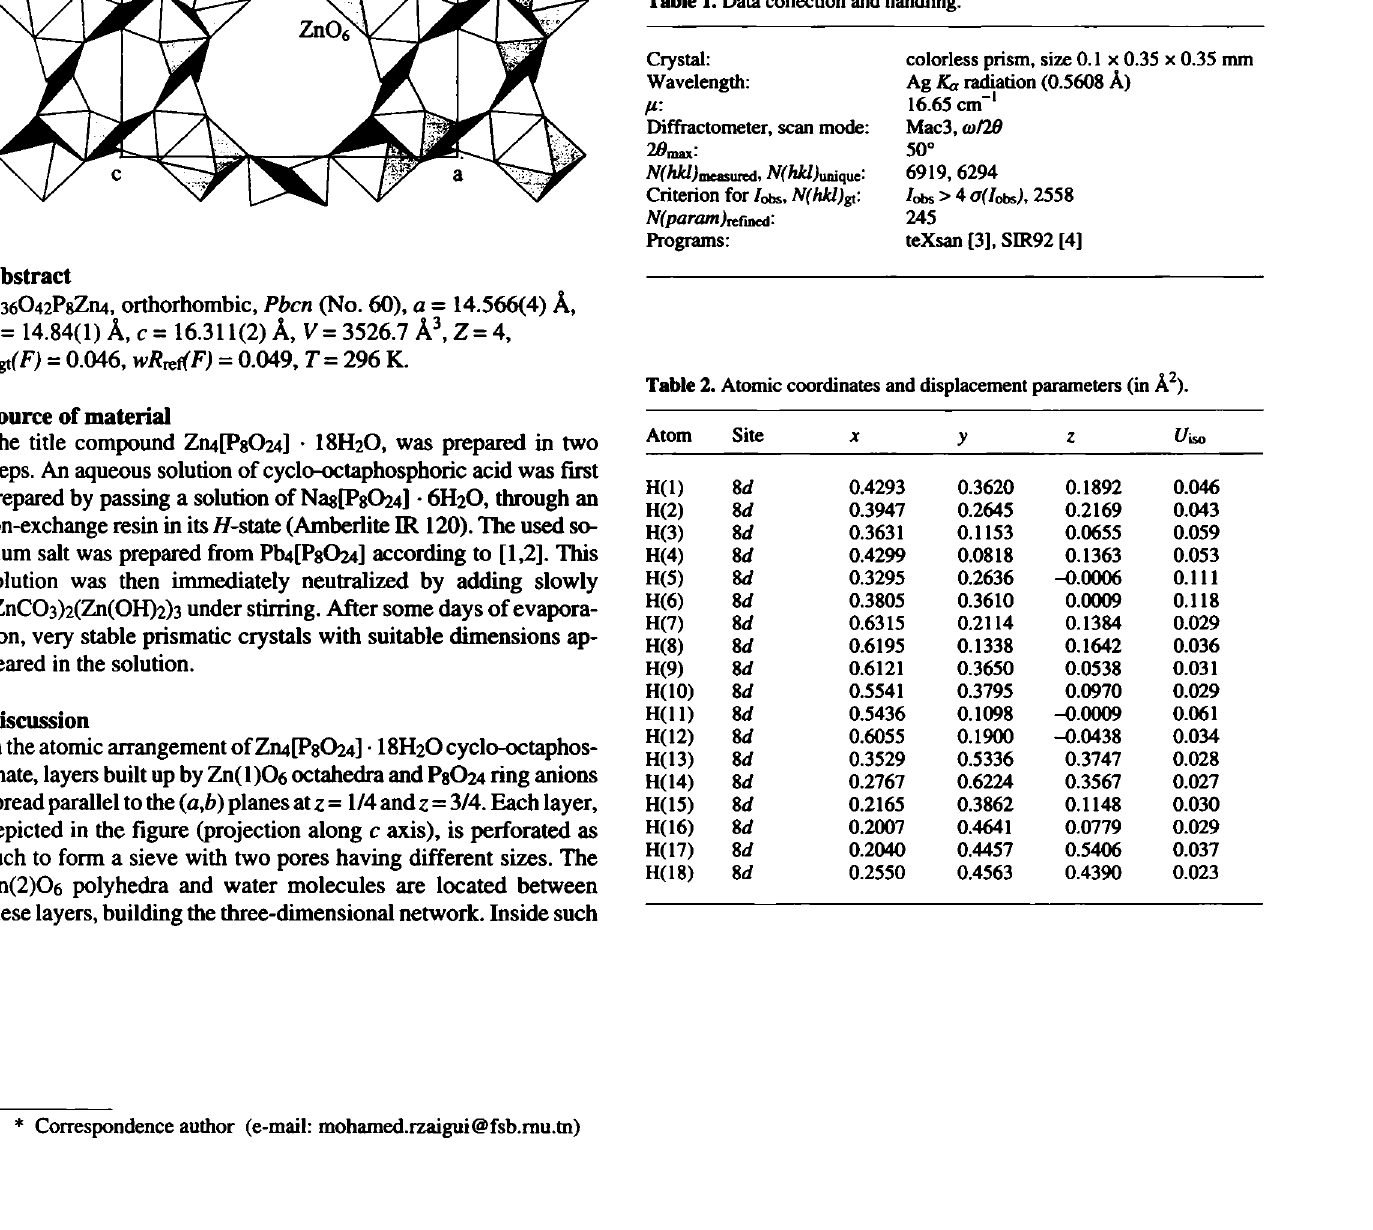
Table 1. Data collection and handling.